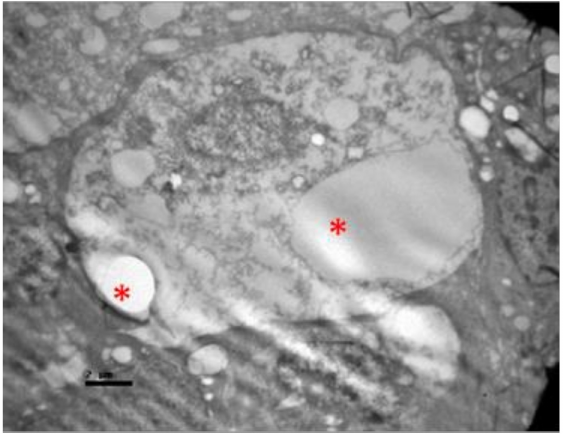
Figure 16. Group M. Degeneration of some photoreceptors’ nuclei (*) and vacuoles in the intercellular space ( ↑ ).